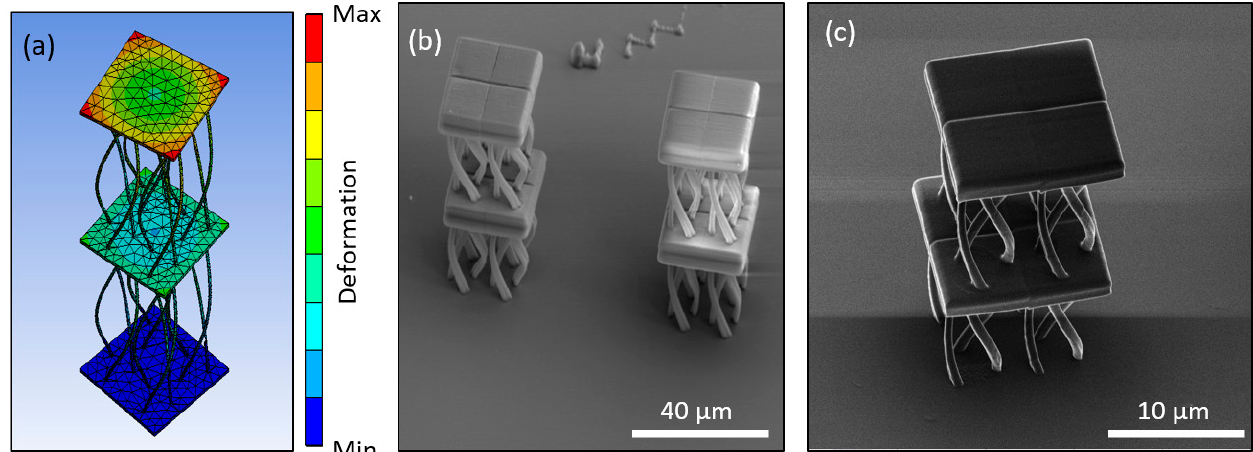
Figure 5. Design and fabrication of the twisting mechanical metamaterial fabricated using Nano-cube at 90mJ/cm 2 and 100 μ m/s scan speed. ( a ) FEA simulation of the structure under loading, revealing the anisotropic response of rotation due to uniaxial loading, ( b ) Isometric view of SEM imaging of such unit cells, and ( c ) Close view of the anisotropic structure using the Helium Ion Microscope.